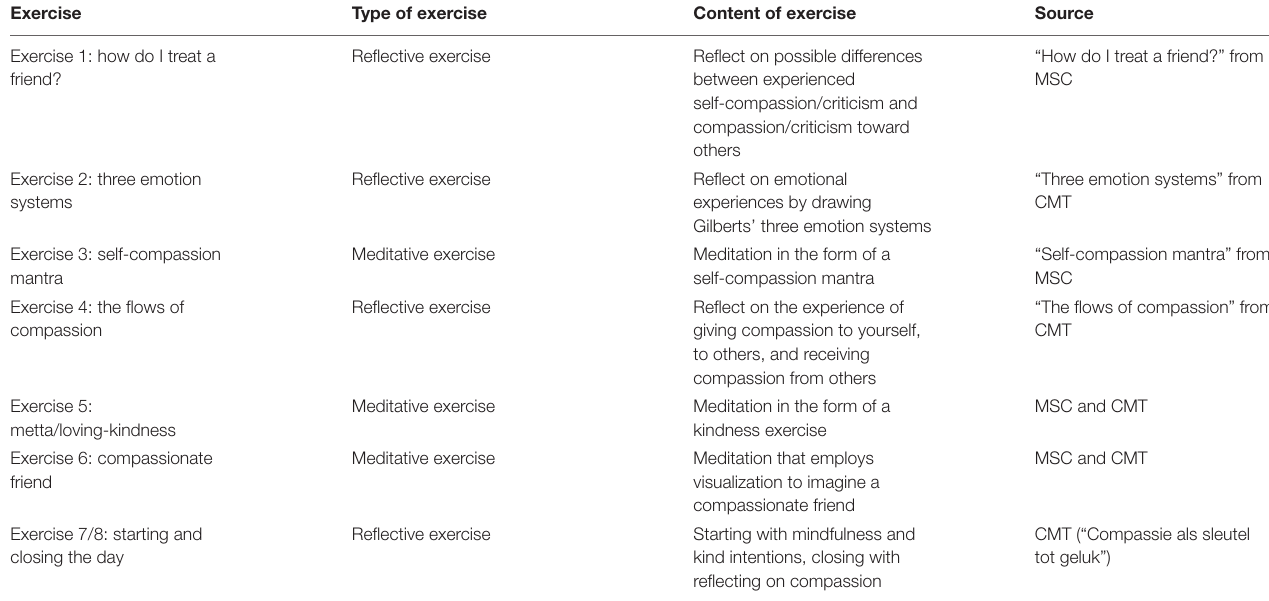
TABLE 1 | Overview of the self-compassion exercises that participants tried out prior to the interviews.